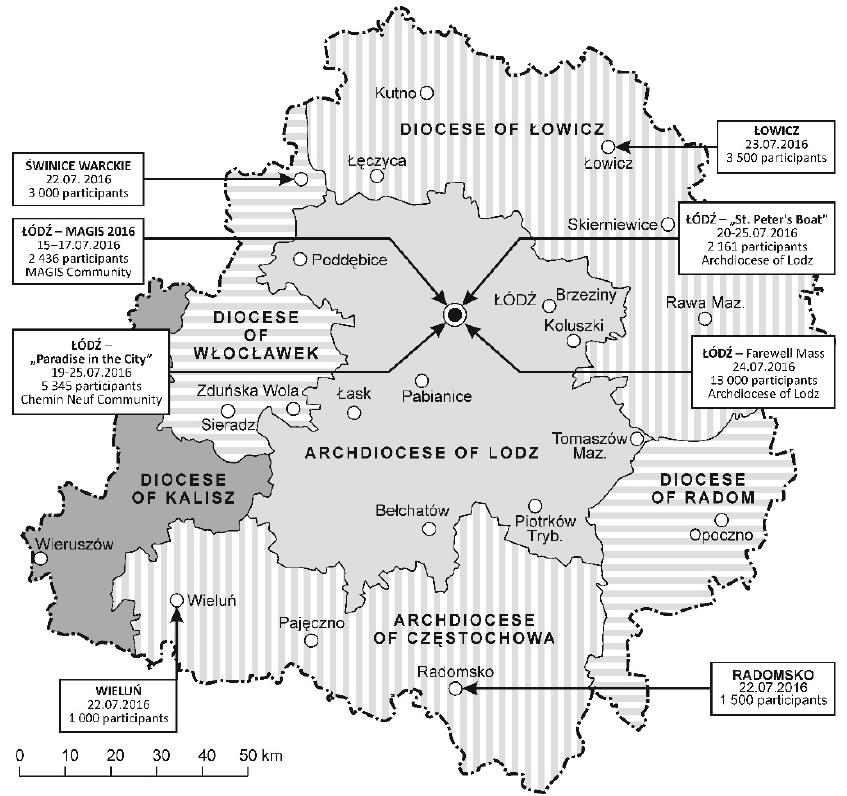
Figure 1. Major World Youth Day (WYD) events in 2016, in Lodz Province (Source: authors).